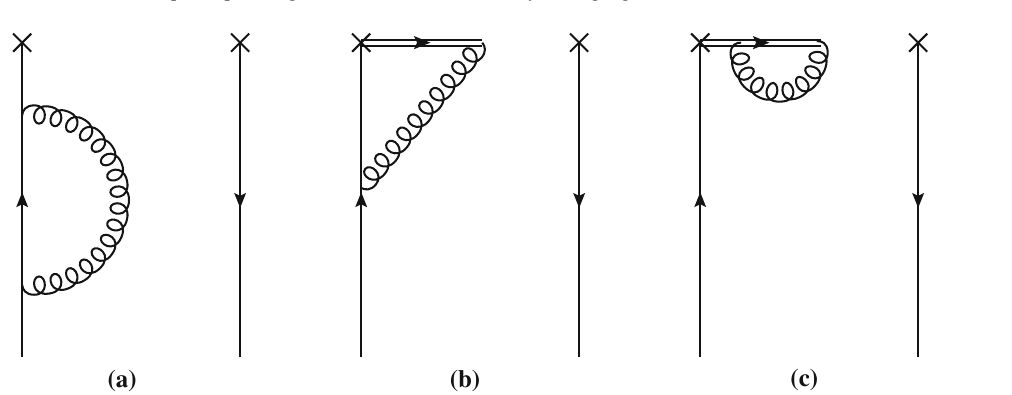
Fig. 4 One-loop real corrections to quark quasi (light-cone) distributions in Feynman gauge